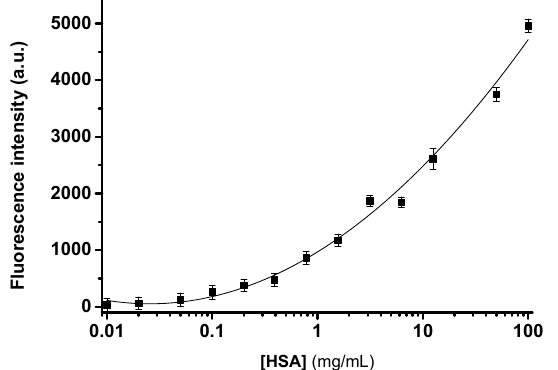
Figure 3. Calibration curve of S1 nanoparticles suspended in PBS (pH 7.4)-acetonitrile 95:5 v / v upon addition of increasing concentrations of HSA (0.1 to 100 mg/mL). All aliquots were taken after 5 min. Error bars are expressed as 3σ for three independent experiments. The lines are included only as a guide to the eye for better illustration.